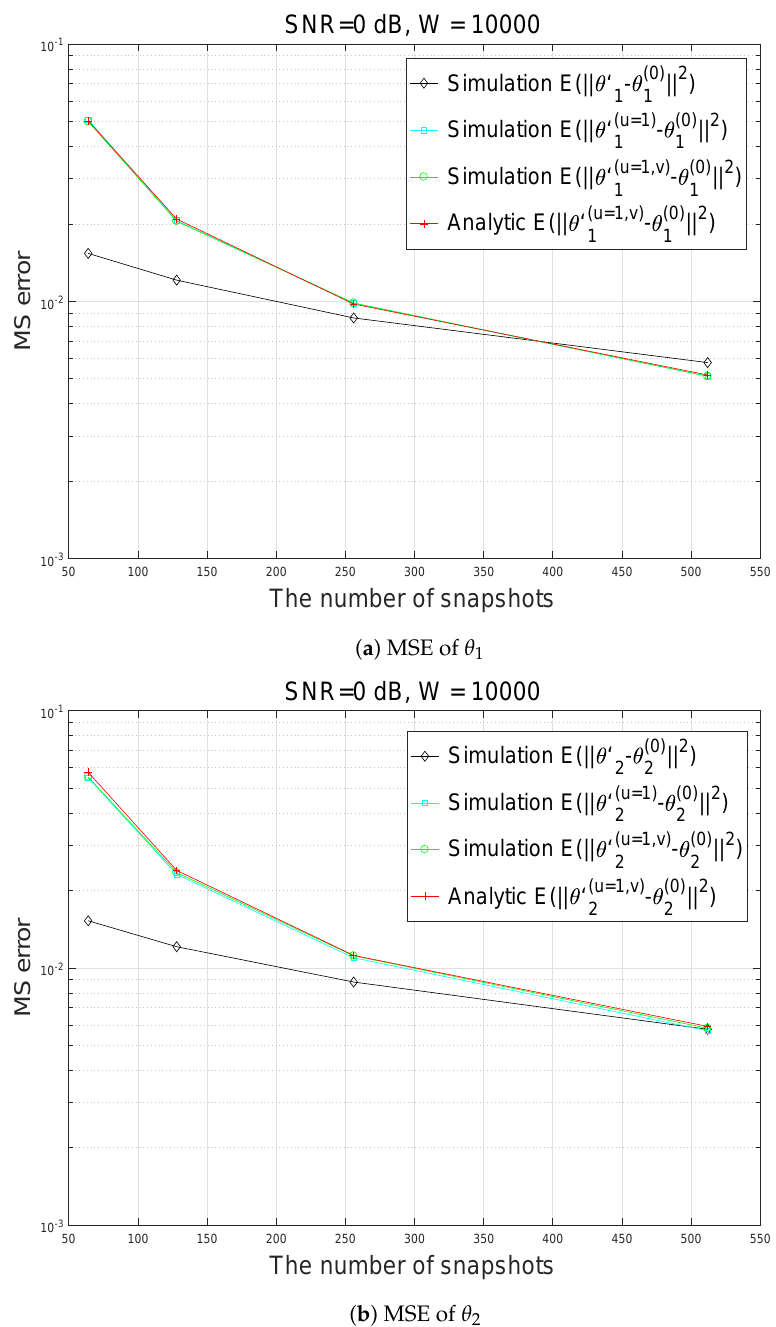
Figure 2. Analytic and simulated MSEs θ 1 and θ 2 with respect to the number of snapshots (SNR = 0